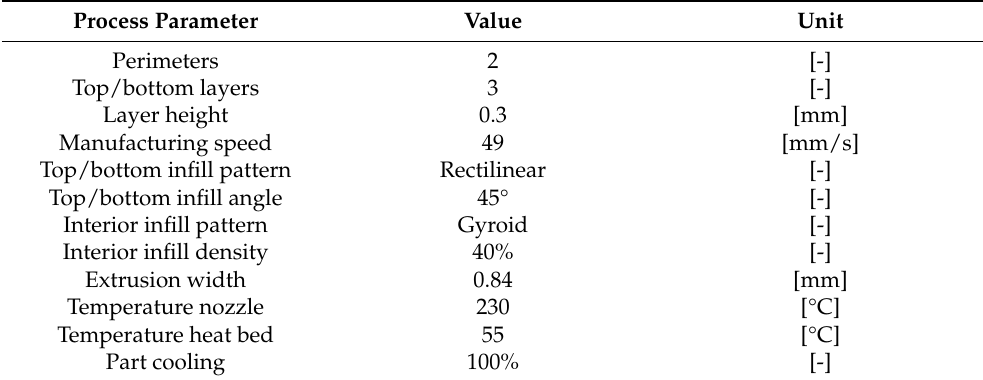
Table 1. Process parameters for the manufacturing of test specimens.